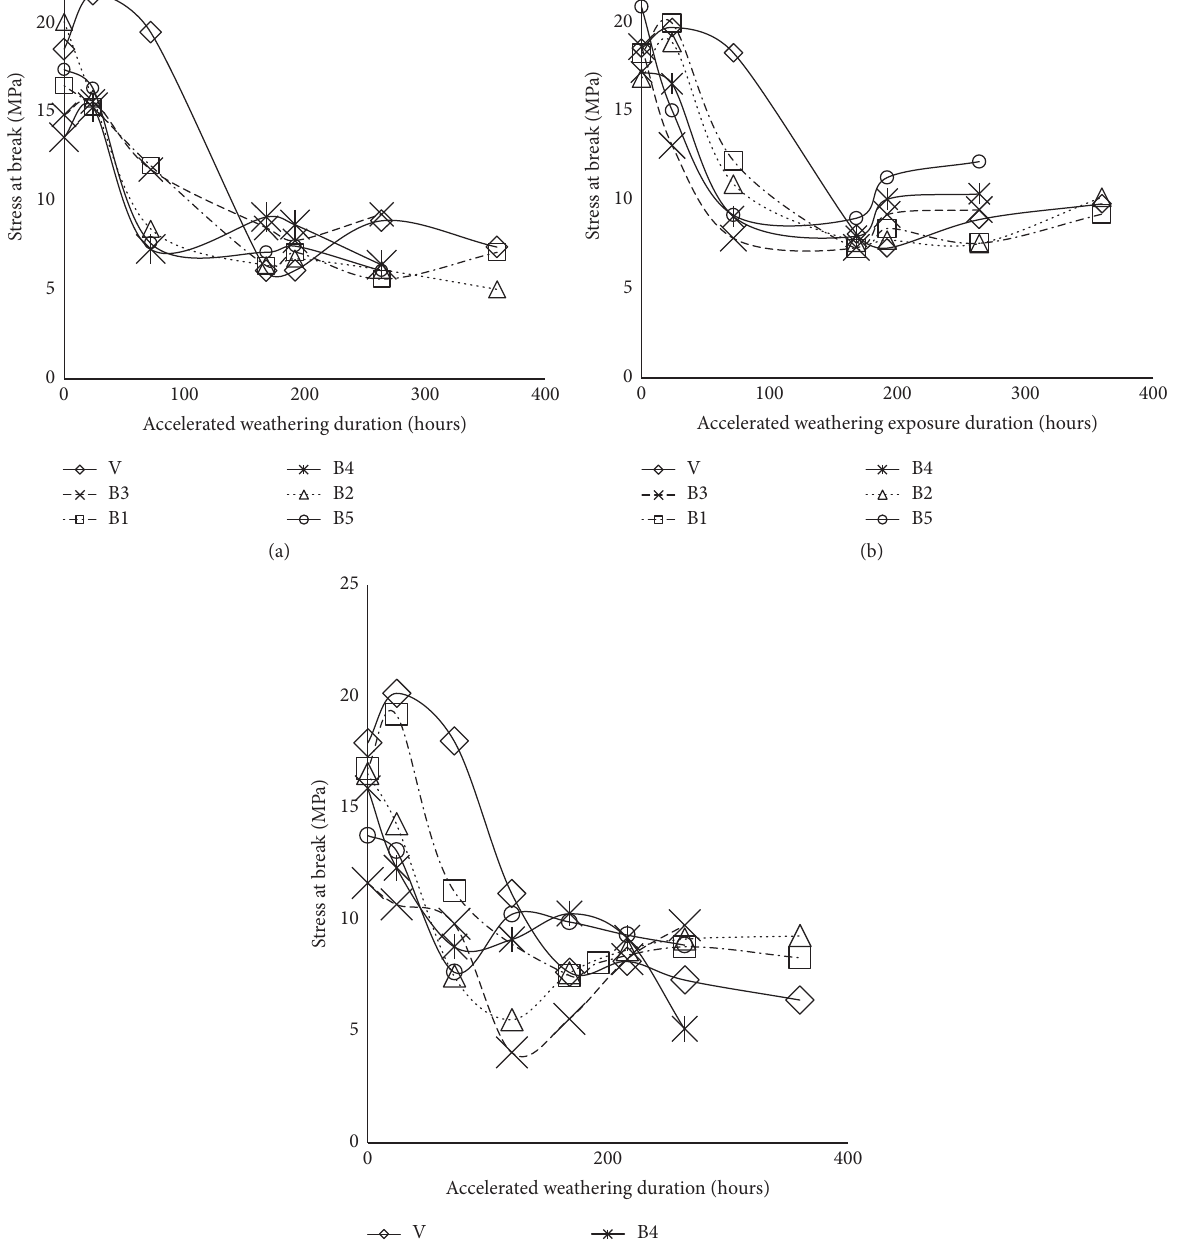
DHTs. This could be attributed to the low amount of waste material in the blend leaving voids that make the samples more transparent than the single polymer product (V). However, samples processed at a DHT of 195 ∘ C were generally more transparent than the samples processed at 175